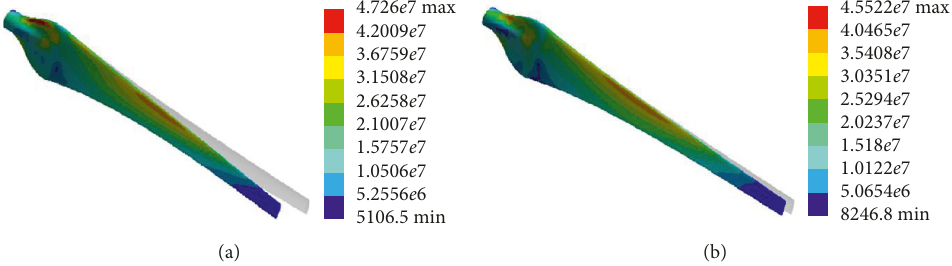
Figure 14: von Mises stress for E-glass-epoxy and basalt-epoxy at 40m/s.